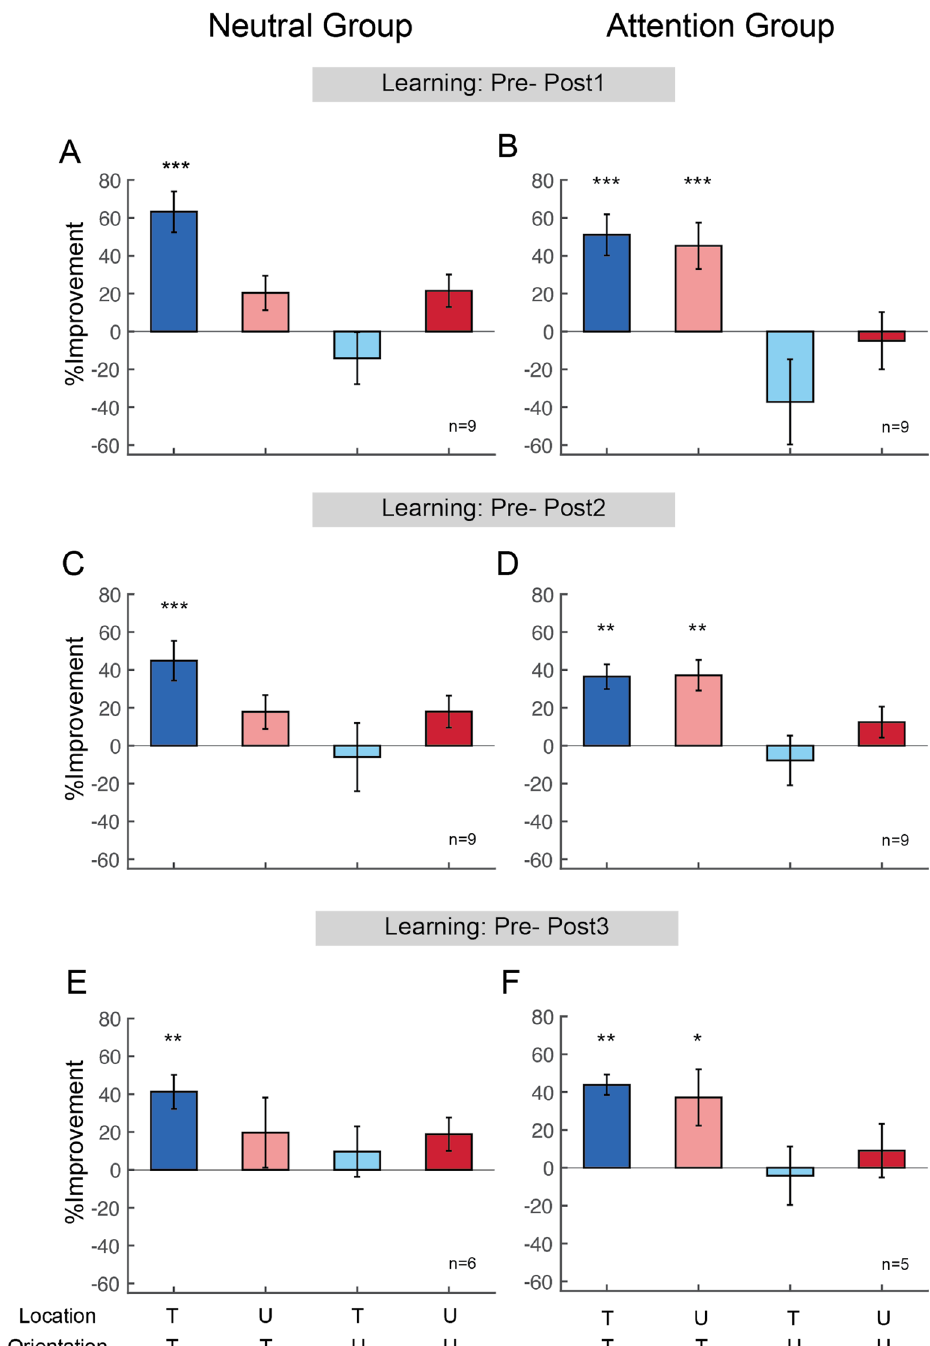
Figure 6. Performance changes at Post-test 1, Post-test 2 and Post-test 3 between the Neutral and Attention groups. ( A,B ) Performance changes between Pre-test and Post-test 1. The Neutral and Attention group showed significant learning in the trained condition (dark blue bars in A , B ). Contrary to the Neutral group, training with FBA unlocked location specificity (light red bar in B ), while preserving orientation specificity (light blue, dark red bars in B ). ( C,D ) Performance changes between Pre-test and Post-test 2. Consistent with the results in Post-test 1, the improvement in both groups (dark blue bars in C , D ) and location transfer in the Attention group (light red bar in D ) were preserved 3–4 months after completion of training. ( E,F ) Performance changes between Pre-test and Post-test 3. The improvement in both groups (dark blue bars in E , F ) and location transfer induced by FBA (light red bar in F ) persisted longer than 1 year after training. * p < 0.05; ** p < 0.01; *** p < 0.001. Error bars represent ± 1 within-subject